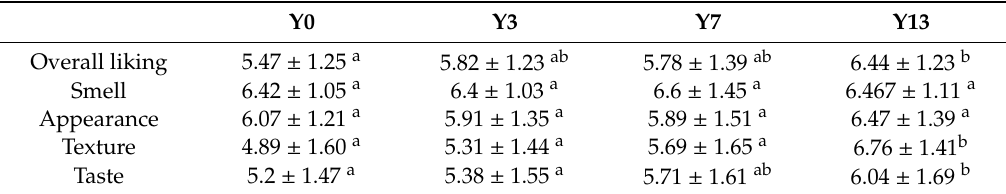
Table 2. Overall liking and acceptability of individual attributes evaluated by the participants ( n = 45) for each yogurt treatment.